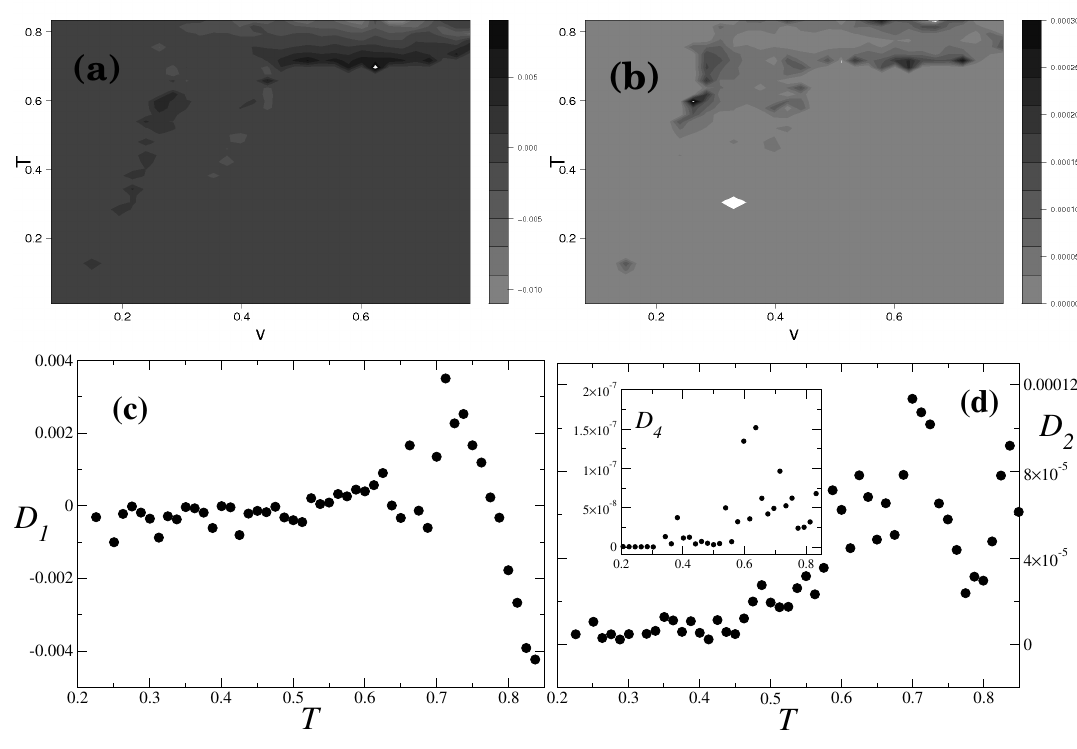
Figure 5. Numerical result for ( a ) the drift D (1) ( T, v ) and ( b ) the diffusion D (2) ( T, v ) in the Langevin Equation (7) from which the time series of the torque is reconstructed. In ( c ) and ( d ), the coefficients are plotted as a function of T alone, i.e. , they are projected at the T -axis to emphasize the linear and quadratic dependency of D (1) and D (2) , respectively, for the largest range of torque values. The numerical values of both functions are the ones used for predicting the torque series in Wind Turbine AV5. In the inset, one sees the lower values of D (4) , which enables us to only consider drift and diffusion (see the text). In the full range of values [0 , 1] , 51 bins were